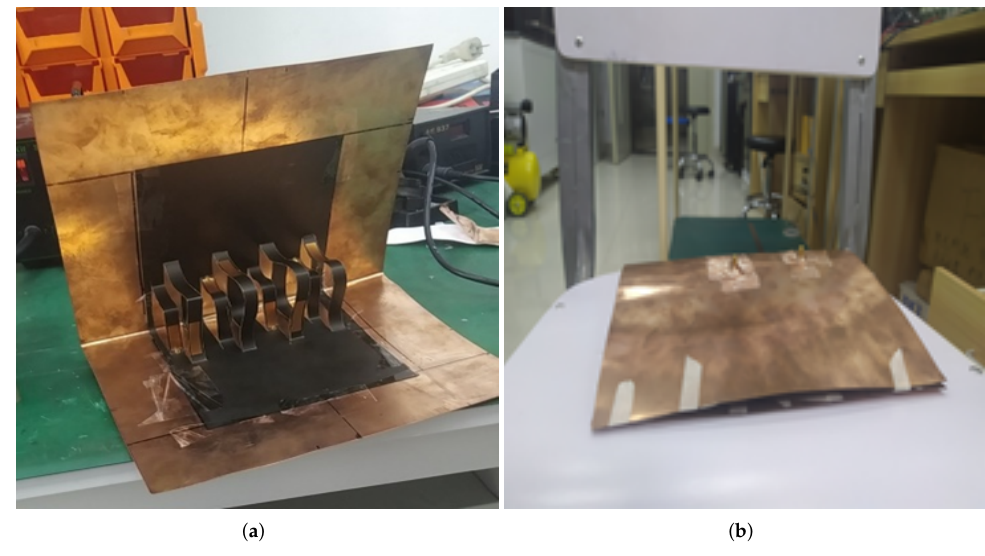
Figure 4. Fabricated prototype of the Kirigami MIMO antenna: ( a ) unfolded state; ( b ) folded state.